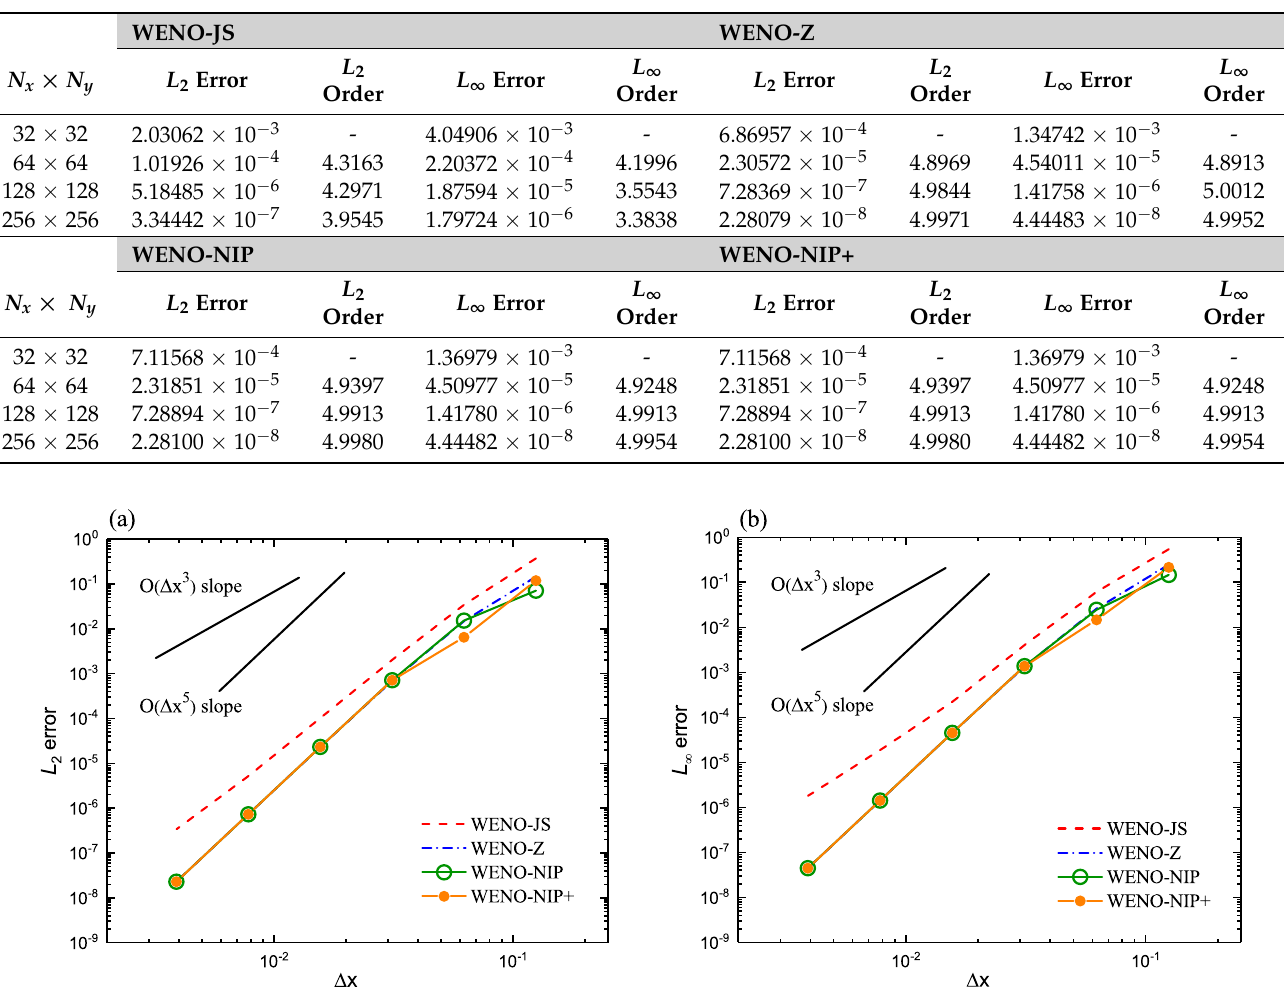
Table 2. Numerical errors and convergence orders of accuracy when solving Example 5, t = 2.0, CFL = h 2/3 .